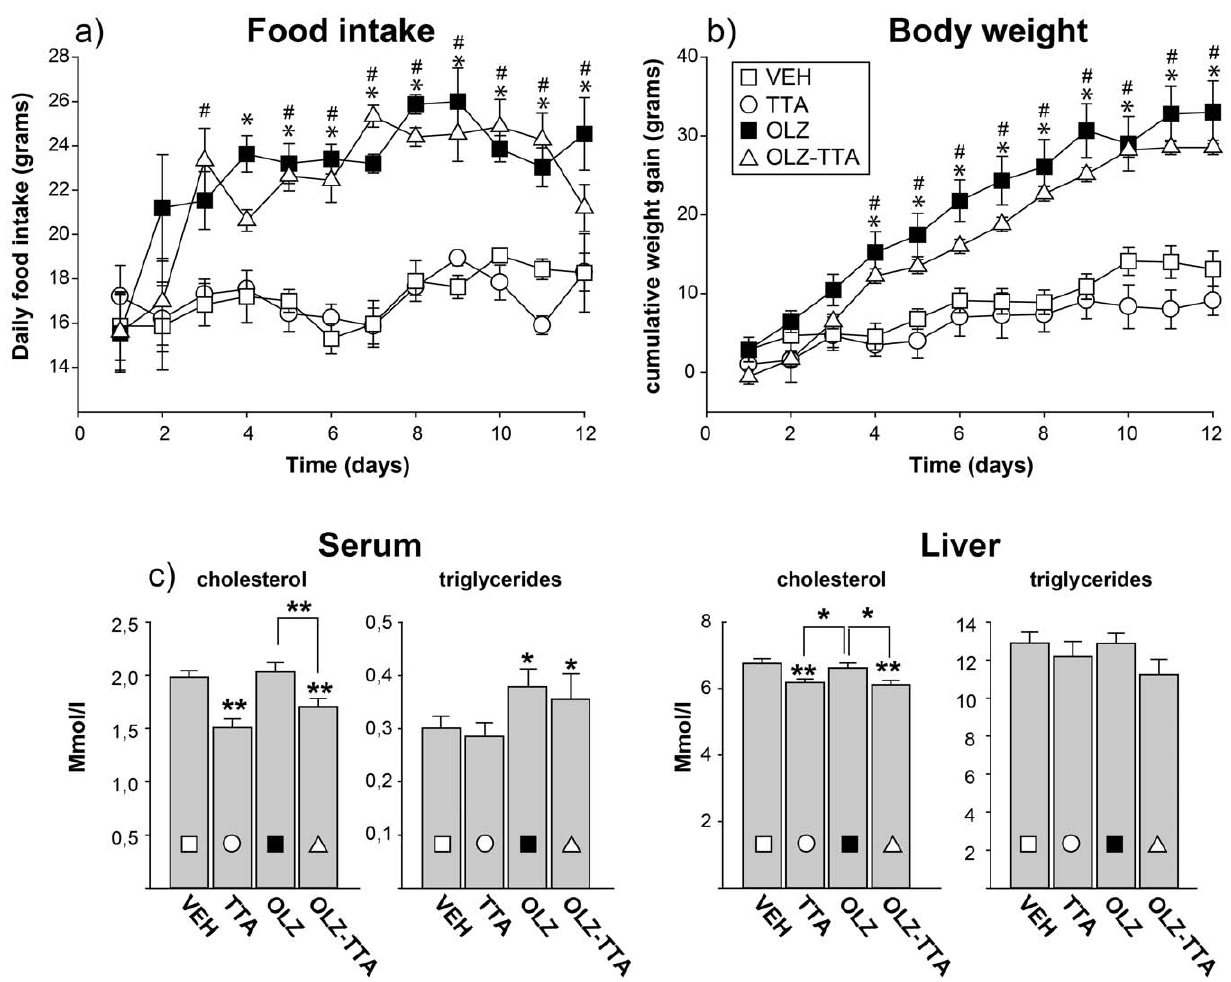
Figure 1. Parameters measured during the subchronic experiment. a) daily food intake, b) daily cumulative weight gain, and c) and serum levels of total cholesterol, triglycerides, liver total cholesterol and triglycerides at the 2-week end point of the subchornic experiment. VEH, vehicle, TTA: tetradecylthioacetic acid, OLZ: olanzapine. * P # 0.05 vs vehicle.